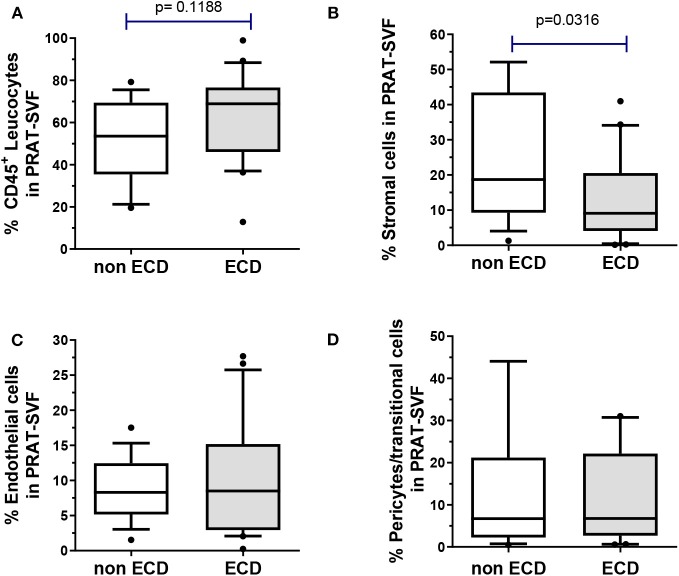
The distribution of cell subsets composing the PRAT-SVF was determined using flow cytometry and compared between the non-ECD and ECD donors: (A) CD45+ leukocytes were comparable in the two groups (B) mesenchymal stem/stromal cells were significantly lowered in the ECD vs. non-ECD group (C) pericytes and transitional cells (D) and endothelial cells were not statistically different between the two groups. ECD, extended criteria donors. Non ECD, non-extended criteria donors. Results on the graphs are reported as box and whiskers plots representative of median values, and 25–75 interquartile ranges (Boxes) and error bars indicative of 10-90 percentile ranges. Dots indicates values out of the 10–90% quartile range.